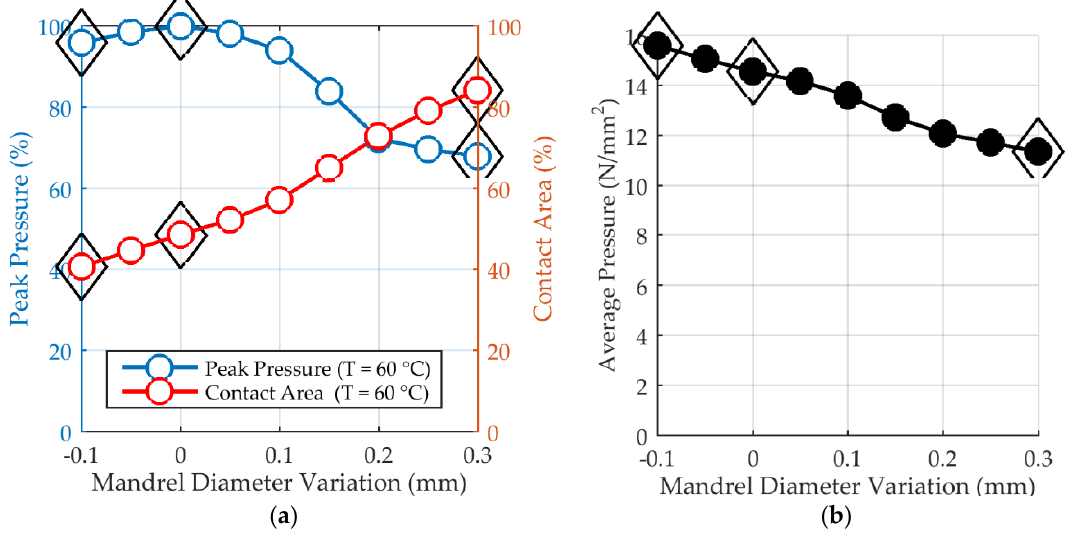
Figure 12. ( a ) Peak contact pressure and contact area between part and mandrel indicating incomplete shrinkage of the part onto the mandrel. ( b ) Average pressure over mandrel diameter variation.